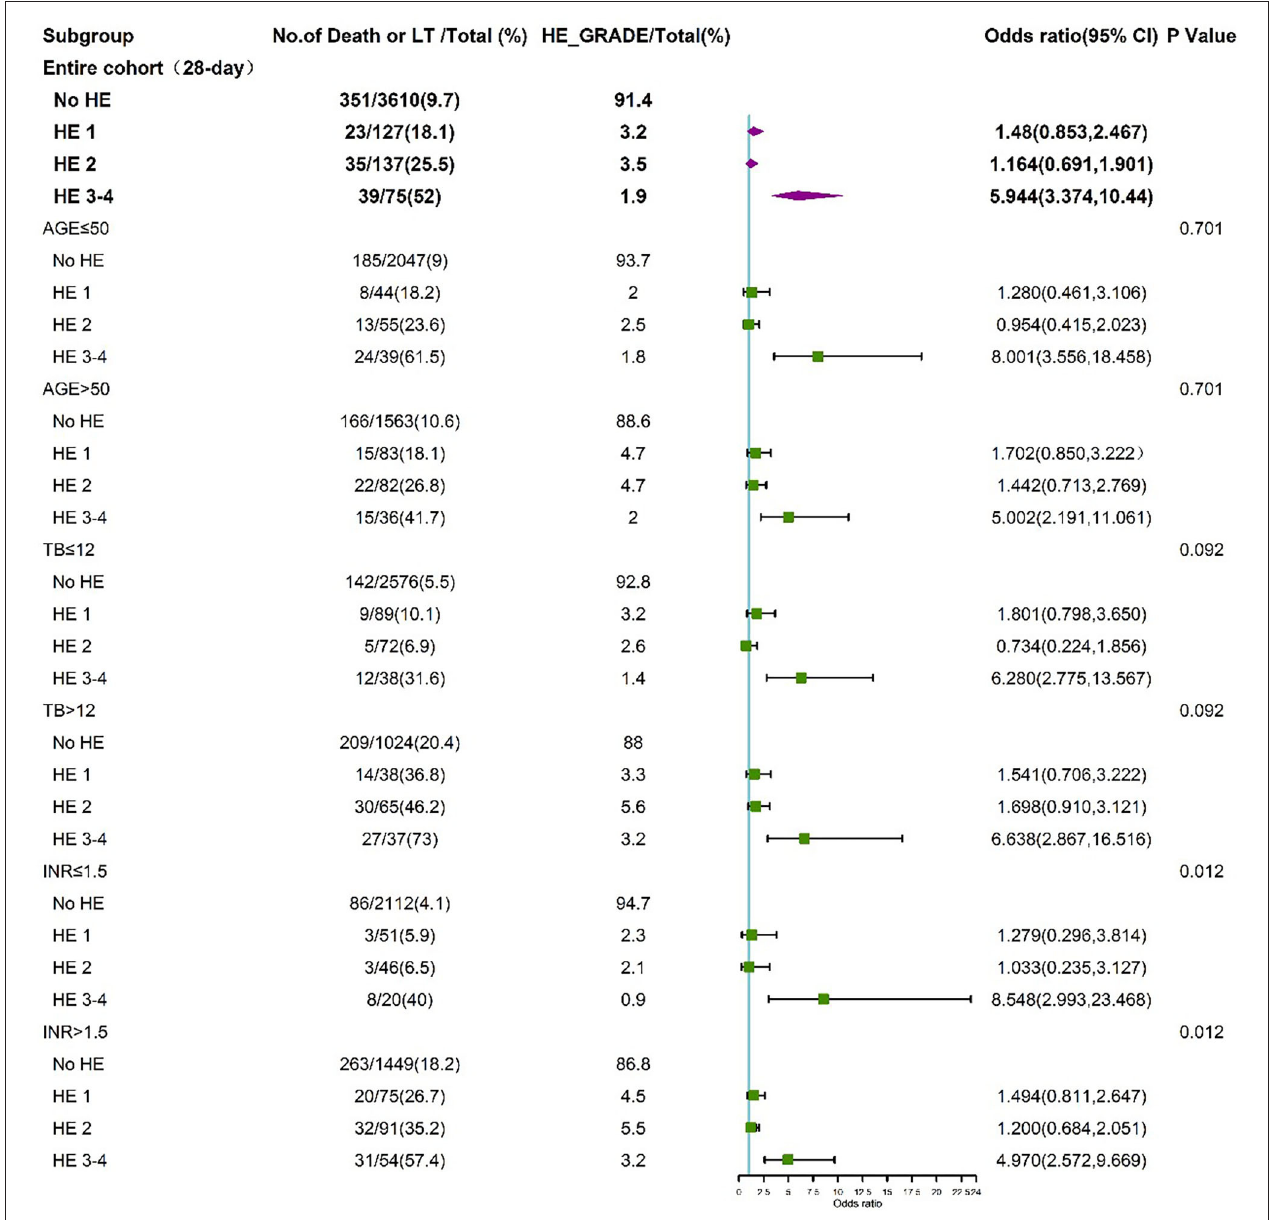
FIGURE 5 | Stratified analyses of 28-day adverse outcomes by HE grades. HE, hepatic encephalopathy; TB, total bilirubin; INR, international normalized ratio; CI, confidence interval.